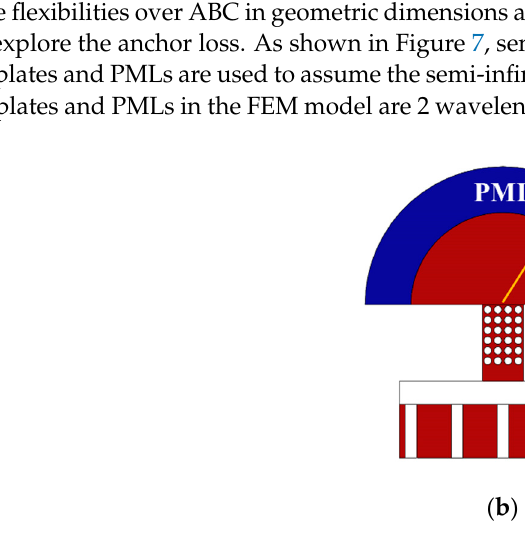
Figure 7. Illustrations of the lamb wave resonators with ( a ) uniform beam anchors and ( b ) PnC slab anchors attaching to the substrate plates covered by perfect match layers (PMLs).